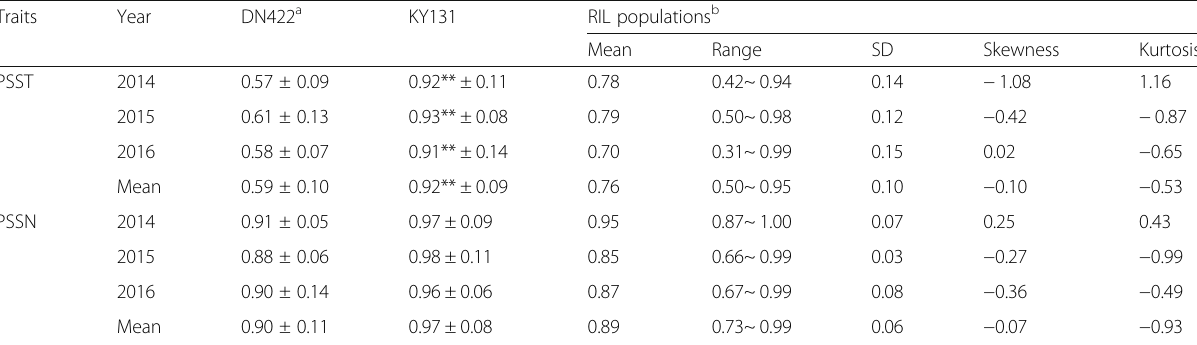
Table 1 PSST and PSSN of parents and RIL population in 3 years